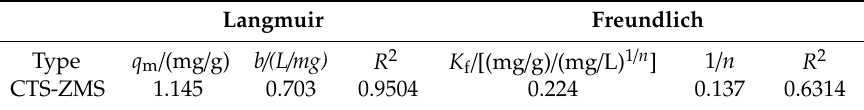
Table 1. The isotherm adsorption model parameters.